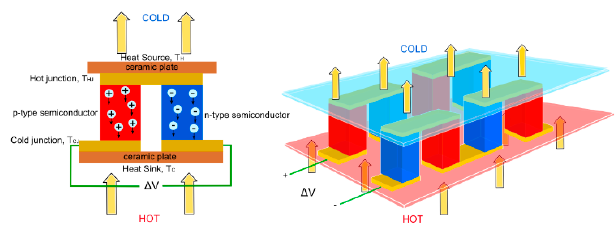
Figure 15. Thermoelectric harvester.